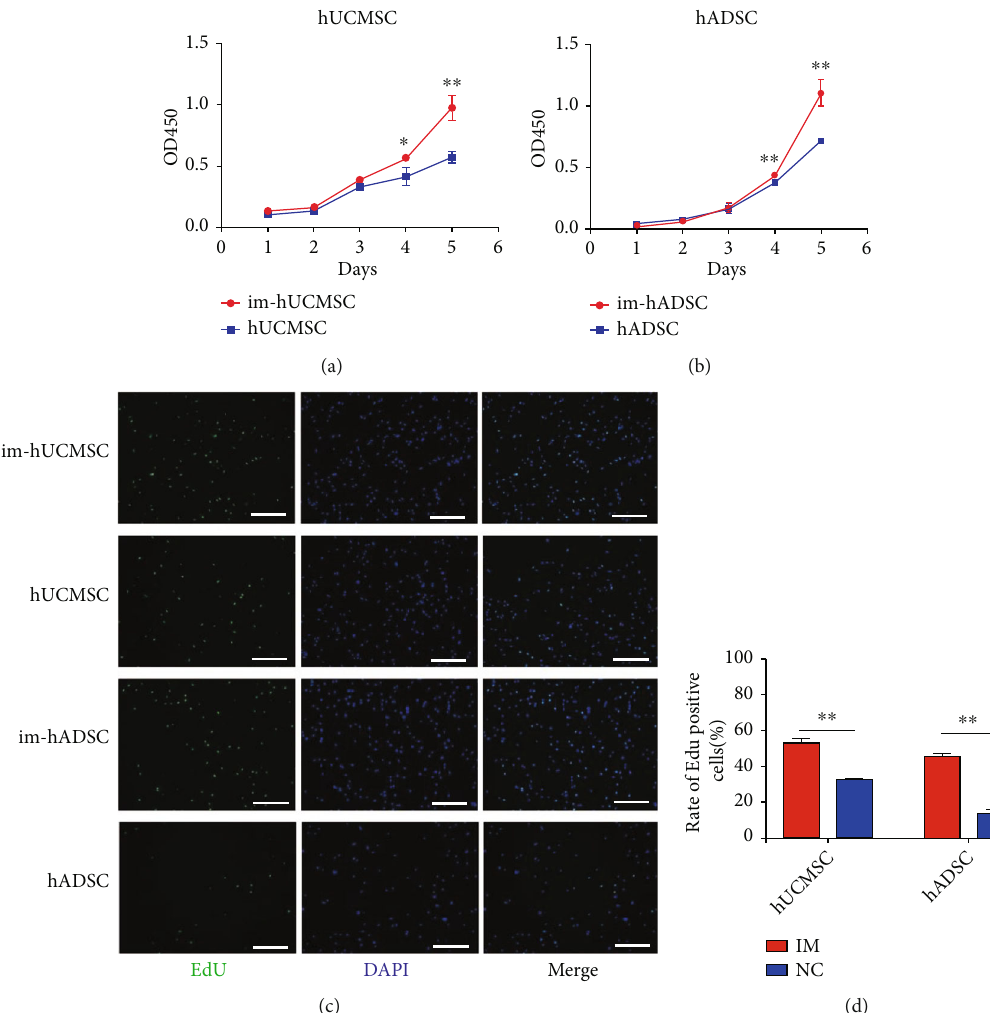
Figure 3: Immortalized mesenchymal stem cells have greater proliferative capacity. (a) and (b) Cell growth curve of hADSC, hUCMSC, and MSCs after transfected by LV-TERT and LV-BMI1, detected by the CCK-8 assay. (c) and (d) By adding EdU reagent, the EdU-positive cells of hADSC, hUCMSC im-hUCMSC, and im-hADSC were detected at two hours later. The rate of EdU-positive cells in hADSC, hUCMSC, im-hUCMSC, and im-hADSC. The results are presented as the mean ± SD of biological triplicate assays. Magni fi cation, × 100. Scale bar, 500 μ m. ∗ P < 0 : 05 , ∗∗ P < 0 : 01 . im-hUCMSC: immortalized human umbilical cord mesenchymal stem cells; im-hADSC: immortalized human adipose-derived mesenchymal stem